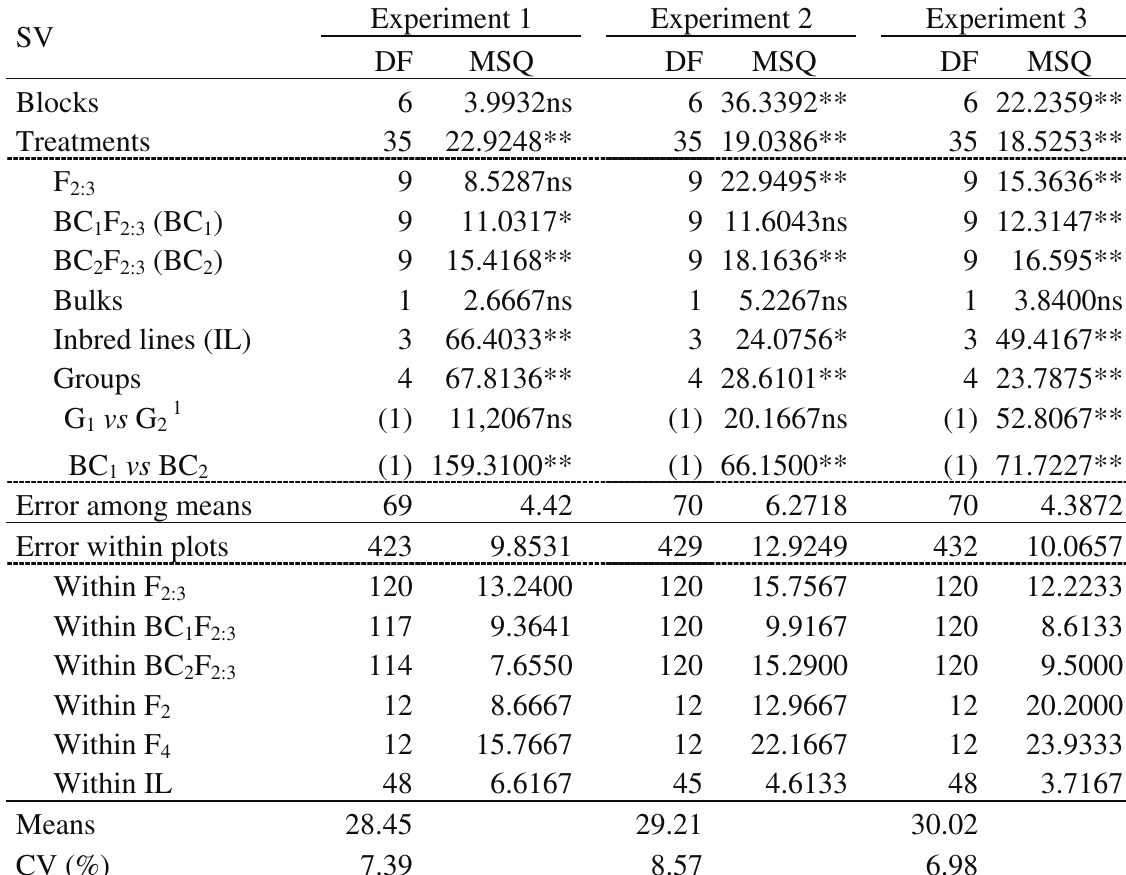
Table S3 – Summary of analysis of variance, with those mean squares associated to variation among the means and within plots from their respective sources of variation, for the trait grain filling period